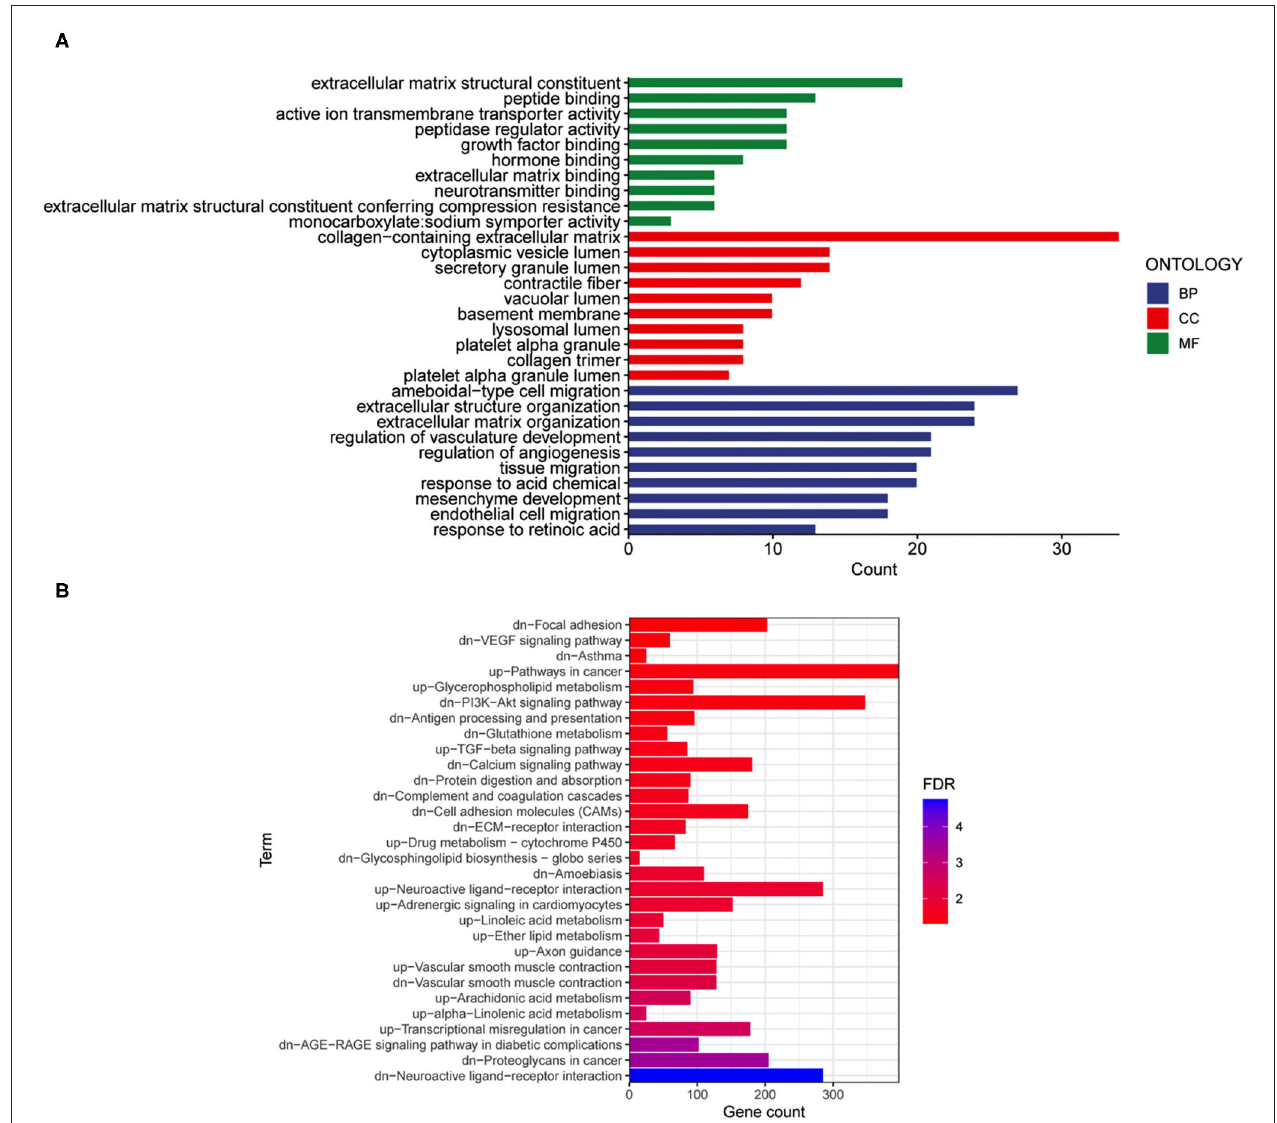
FIGURE 4 | Gene ontology and KEGG enrichment analyses were performed for the mRNAs changed after fear memory extinction and updating. (A,B) The DEGs in E and RE groups were analyzed by GO (A) and KEGG (B) . GO, gene oncology; KEGG, Kyoto Encyclopedia of Genes and Genomes; DEGs, differentially expressed genes.